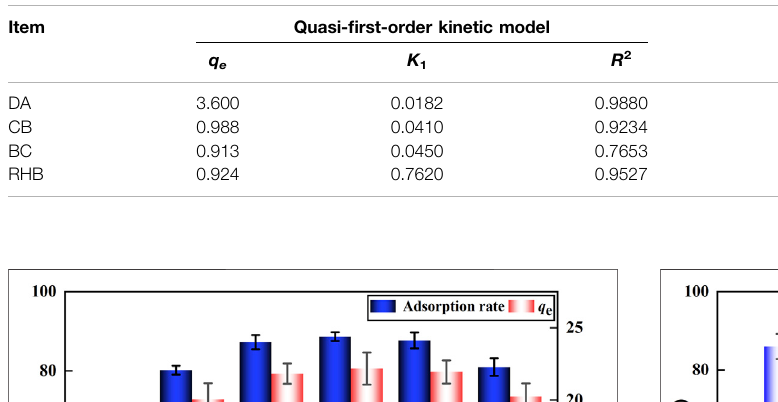
TABLE 2 | Kinetic fi tting parameters of four different materials for F - adsorption.